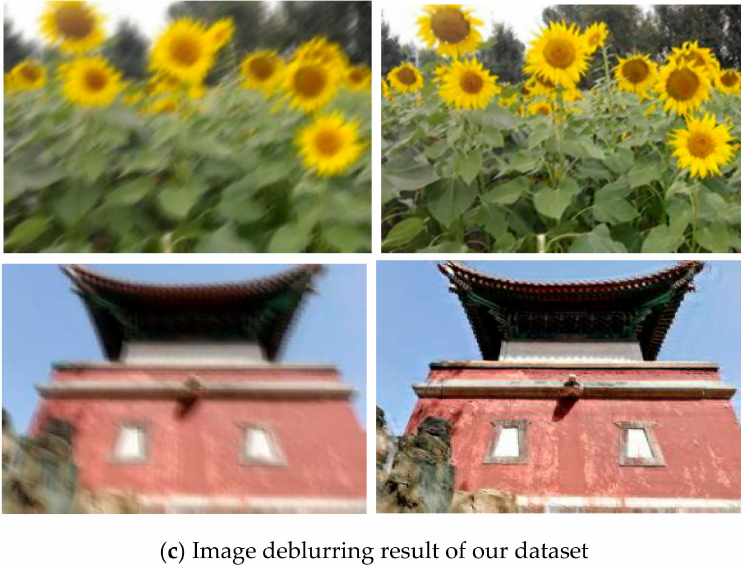
Figure 15. The deblurring results of natural